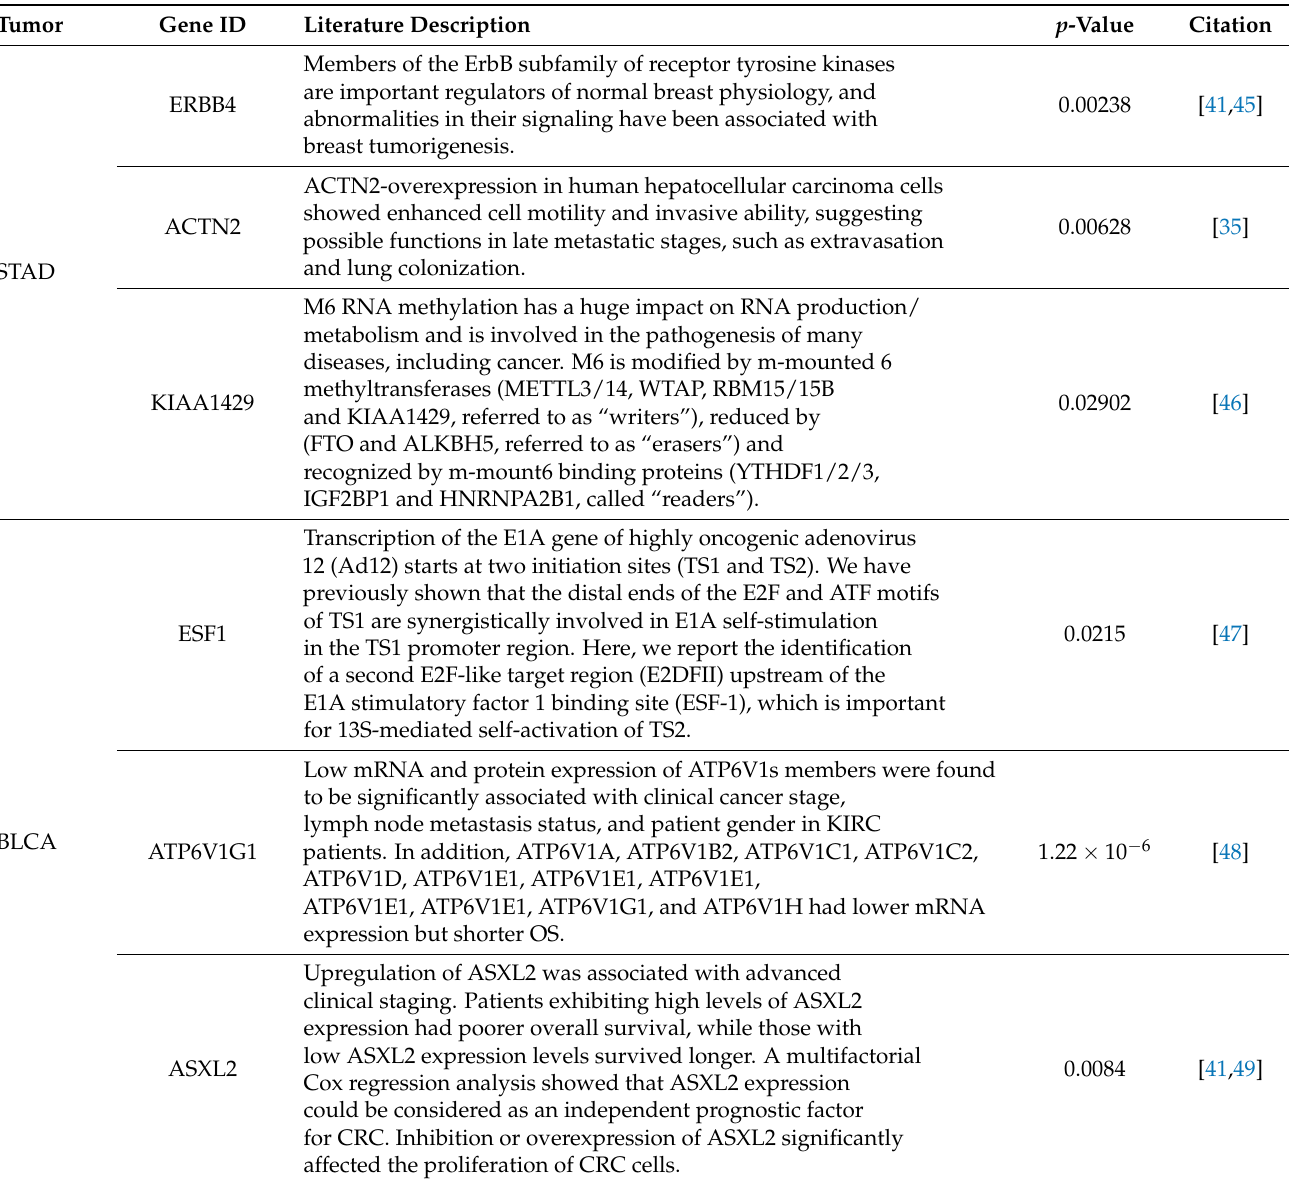
Table A1. Newly predicted cancer driver genes by the GGraphSAGE model. Screening of the literature and p -value, including gene ID, gene functions, statistical p -value of the association between the gene’s mutation and cell proliferation, and reference of existing